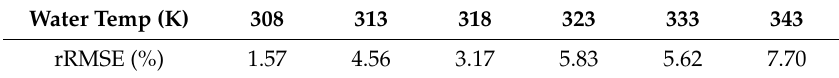
Table 3. rRMSE between the measured data and predicted data of the residual lipase activity. Water Temp